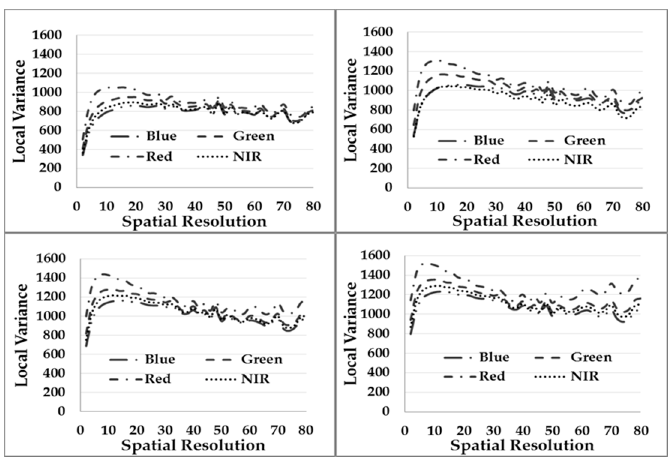
Figure 4. Local variance plots of PMF in Guyuan. Table 3. The appropriate spatial scales obtained from the average local variance (ALV) in Jizhou and Guyuan.